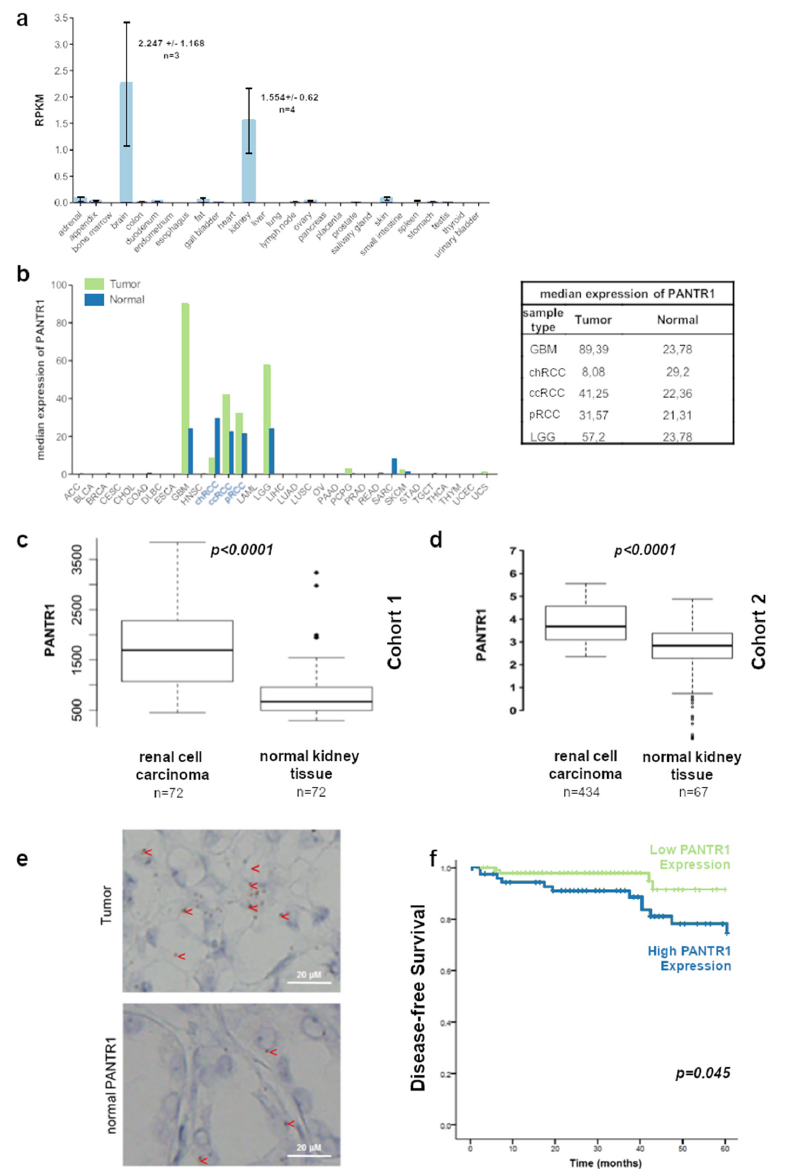
Figure 1. PANTR1 expression is increased in clear-cell renal cell carcinoma (ccRCC) and is associated with significantly shorter recurrence-free survival. ( a ) RNA-sequencing data showing the tissue specific expression of PANTR1 of normal samples from 95 human individuals representing 27 different tissues. Data were derived from a publicly available database (project ID: PRJEB4337, https://www.ncbi.nlm.nih.gov/bioproject/?term=PRJEB4337). ( b ) Gene expression profile of PANTR1 across tumor samples (green) and paired normal tissue (blue). The height of the bars represents the median expression. Data were derived from the publicly available Gepia-server. GBM: glioblastoma multiforme; chRCC: chromophobe RCC; ccRCC: clear-cell RCC; pRCC: papillary RCC; LGG: brain lower grade glioma. ( c , d ) PANTR1 expression in ccRCC versus normal kidney tissue of two different cohorts indicate higher expression levels in cancerous tissue. ( e ) Representative images of PANTR1 RNA in-situ hybridization on kidney tumor tissue (upper panel) and normal kidney tissue (lower panel). The brown dots representing PANTR1 signal mainly in the nucleus and are indicated by a red arrow head. ( f ) Kaplan-Meier plot comparing 5-year disease-free survival of ccRCC patients stratified by PANTR1 expression (low in green vs. high in blue, n = 175, p = 0.045).